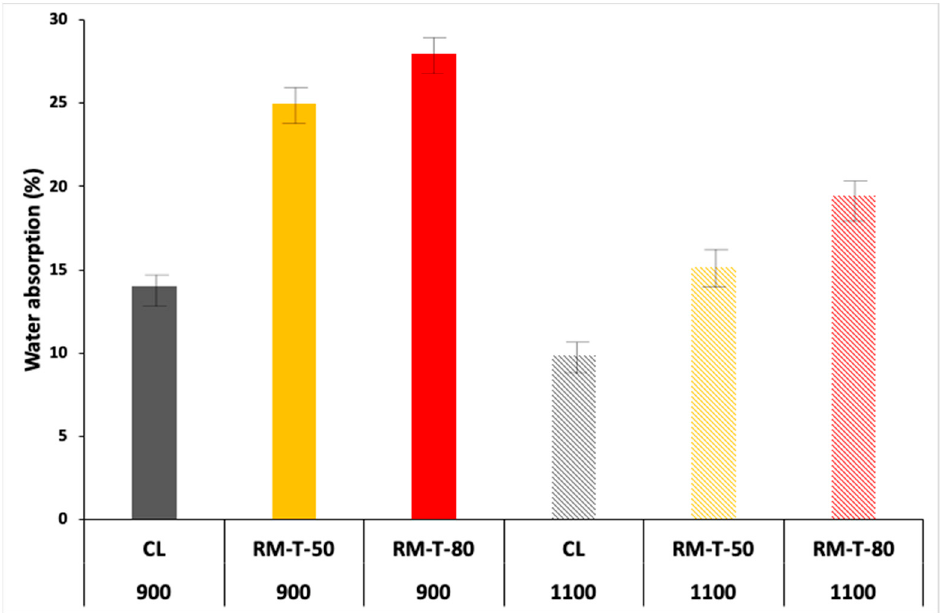
Figure 6. Water absorption of samples after sintering.